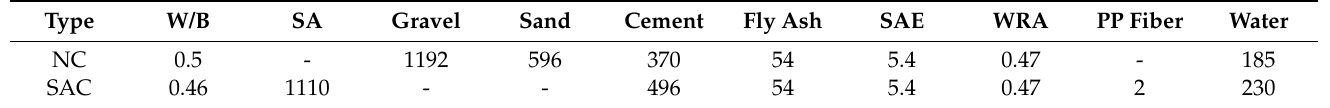
Table 1. Mix proportion (kg/m 3